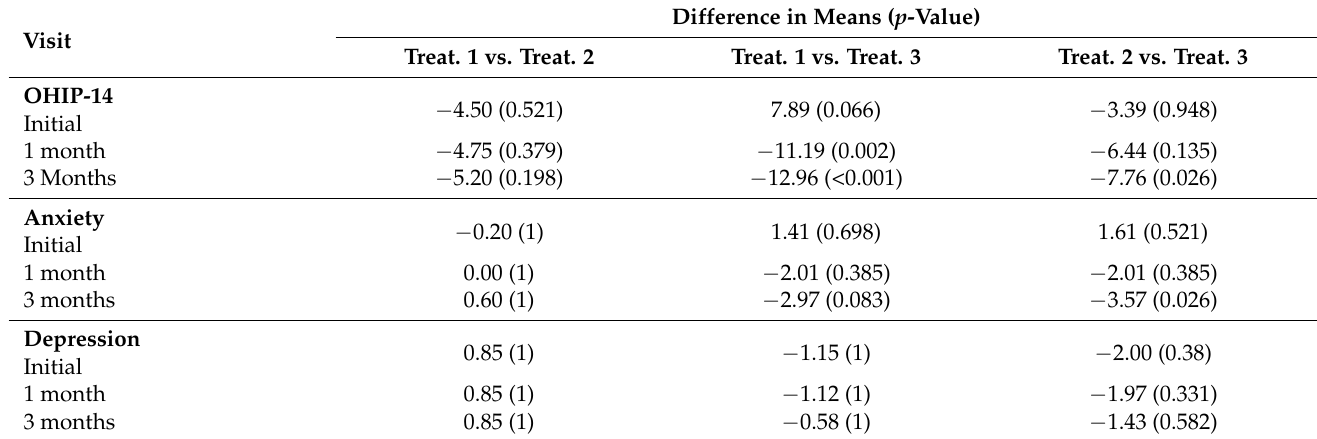
Table 6. Differences in means and p -values between the treatment groups at each of the visits.